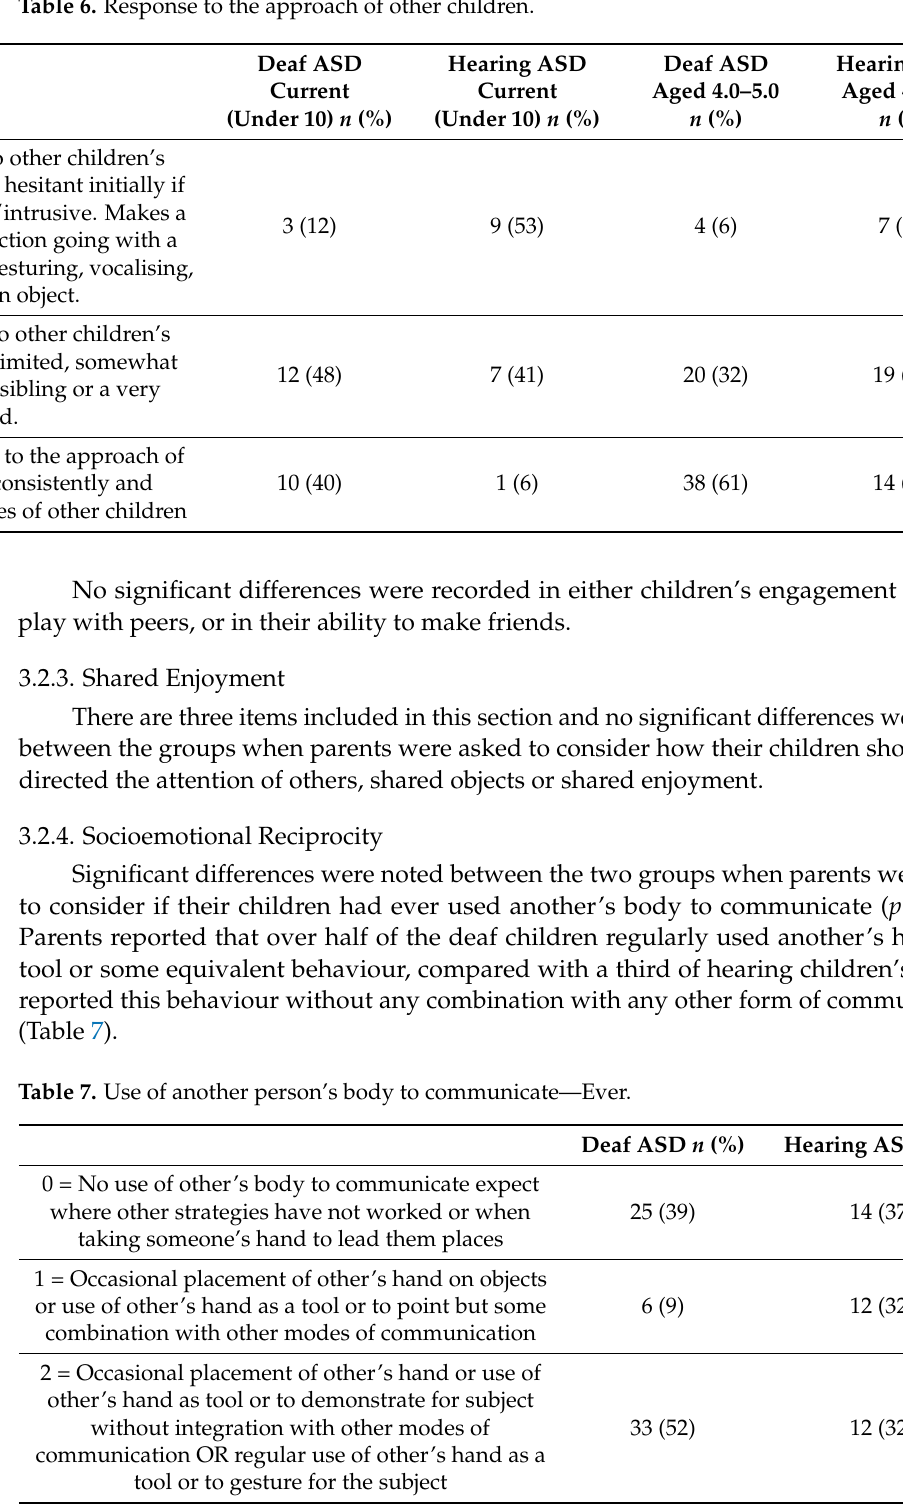
Table 6. Response to the approach of other children.